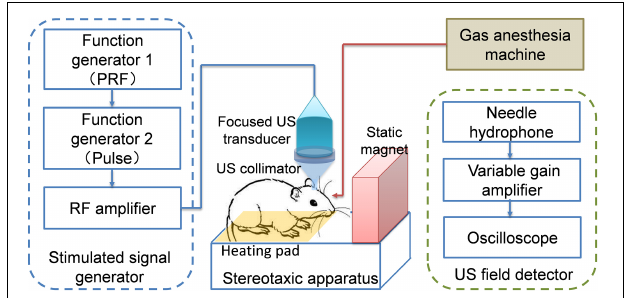
FIGURE 2 | Schematic diagram of the TMAS system for small